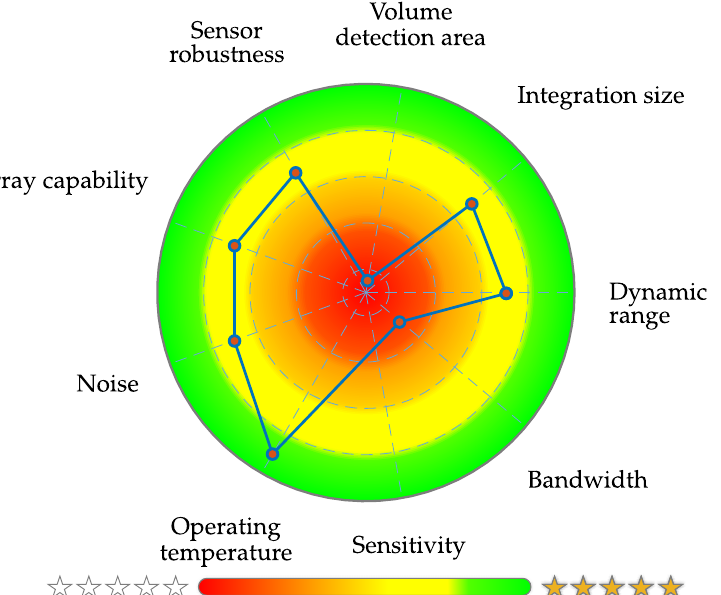
Figure 14. Exemplary prototype design for a clear presentation of application-related metrics